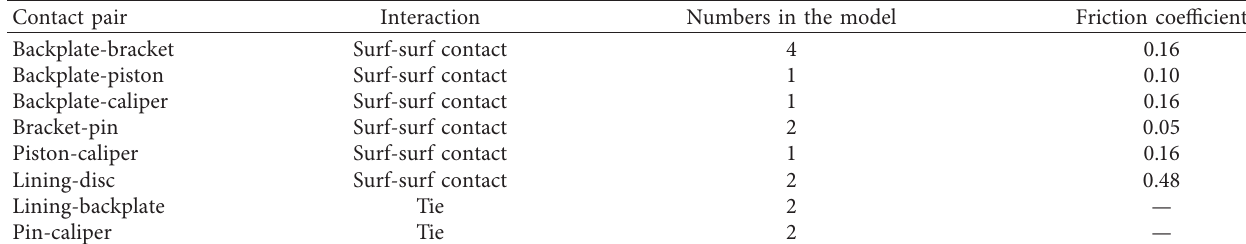
Table 2: Interactions in the brake system finite element